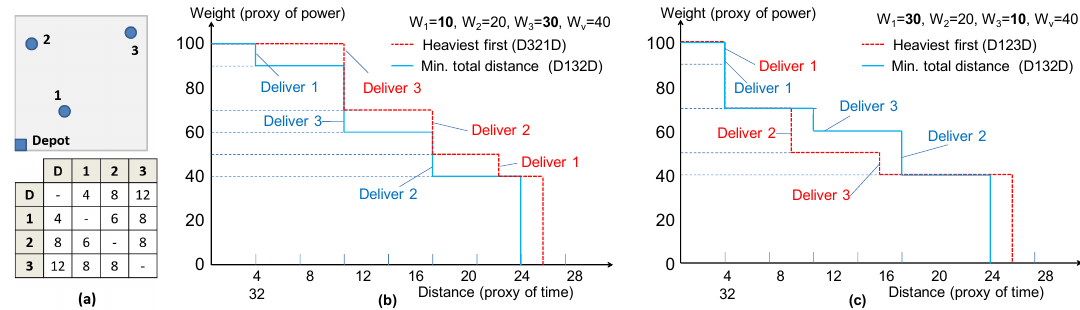
Figure 1. Example to illustrate the motivation of energy-optimal delivery route exploration cannot only depend on single static metric: a delivery task ( a ) and delivery routes for two different delivery weights ( b , c